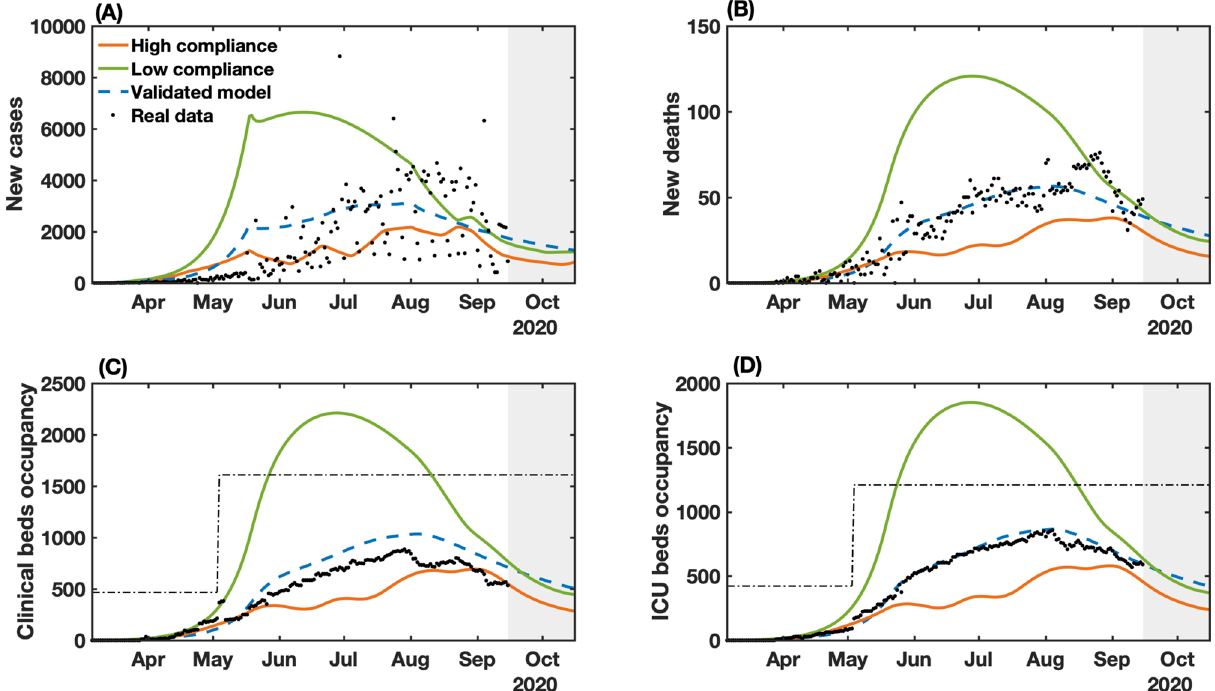
Figure 5. NMPC-controlled simulated epidemic unfolding compared to real-world data in Bahia, Brazil. ( A ) New cases; ( B ) deaths; ( C ) clinical hospitalization and ( D ) ICU bed requirements at the state level. The dashed-blue lines represent the dynamics of the validated model presented in Fig. 2 considering the observed SMRI time series in Fig. 3B. The dashed-dotted lines represent the clinical and ICU bed limits, increased from May on, from 466 to 1610 for clinical beds and from 422 to 1210 for ICU beds. Raw data (black dots) from March 6 to September 15, 2020, are shown in this graph with a daily timescale. The high ( K ψ = 1.1247 ) and low ( K ψ = 0.8374 ) compliance scenarios represent the level of social mobility response related to the applied government